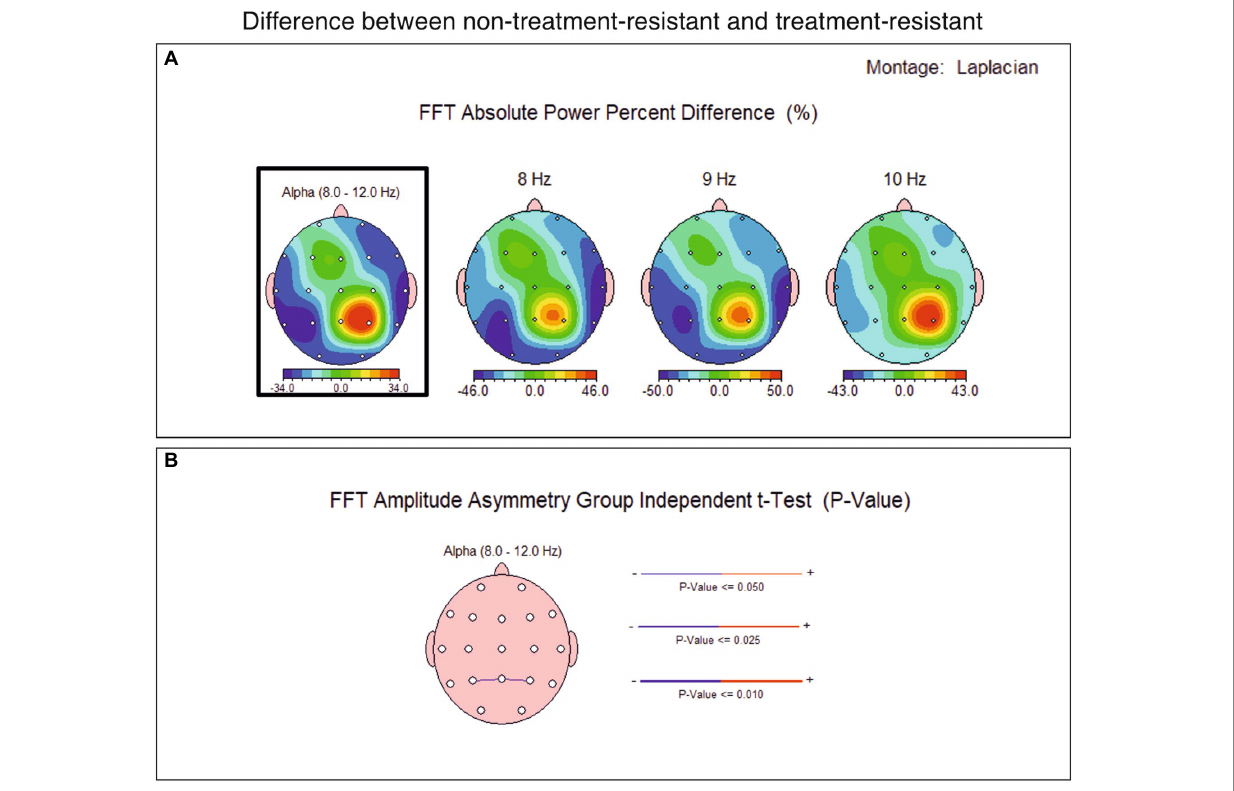
FIGURE 5 (A) Topographical distribution of alpha average power percent difference between major depression group non-treatment-resistant (non-TRD) and treatment-resistant depression group (TRD), showing a 34% difference for the alpha band (8–120 Hz) at P4 site and a maximum difference at 9 Hz: 50% bigger at P4 in the non-TRD group. (B) Difference in FFT amplitude asymmetry across all sites between non-TRD and TRD group, showing a slight significant value ( p < 0,05) at P3-P4 sites in conventional alpha band (bottom). The thin blue line linking P3 and P4 sites is interpreted as smaller alpha asymmetry at the parietal site, for the non-TRD